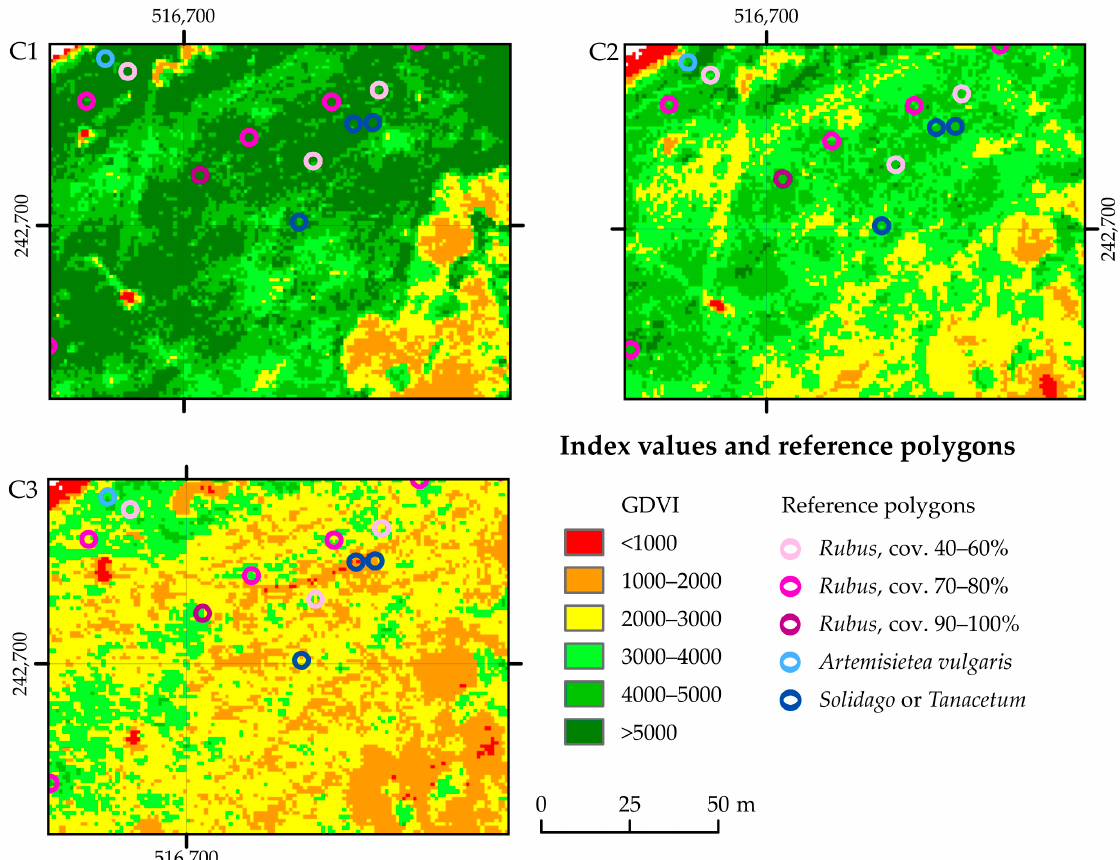
Figure 9. The spatial distribution of the Green Difference Vegetation Index (GDVI) classes for the three campaigns in the selected area.